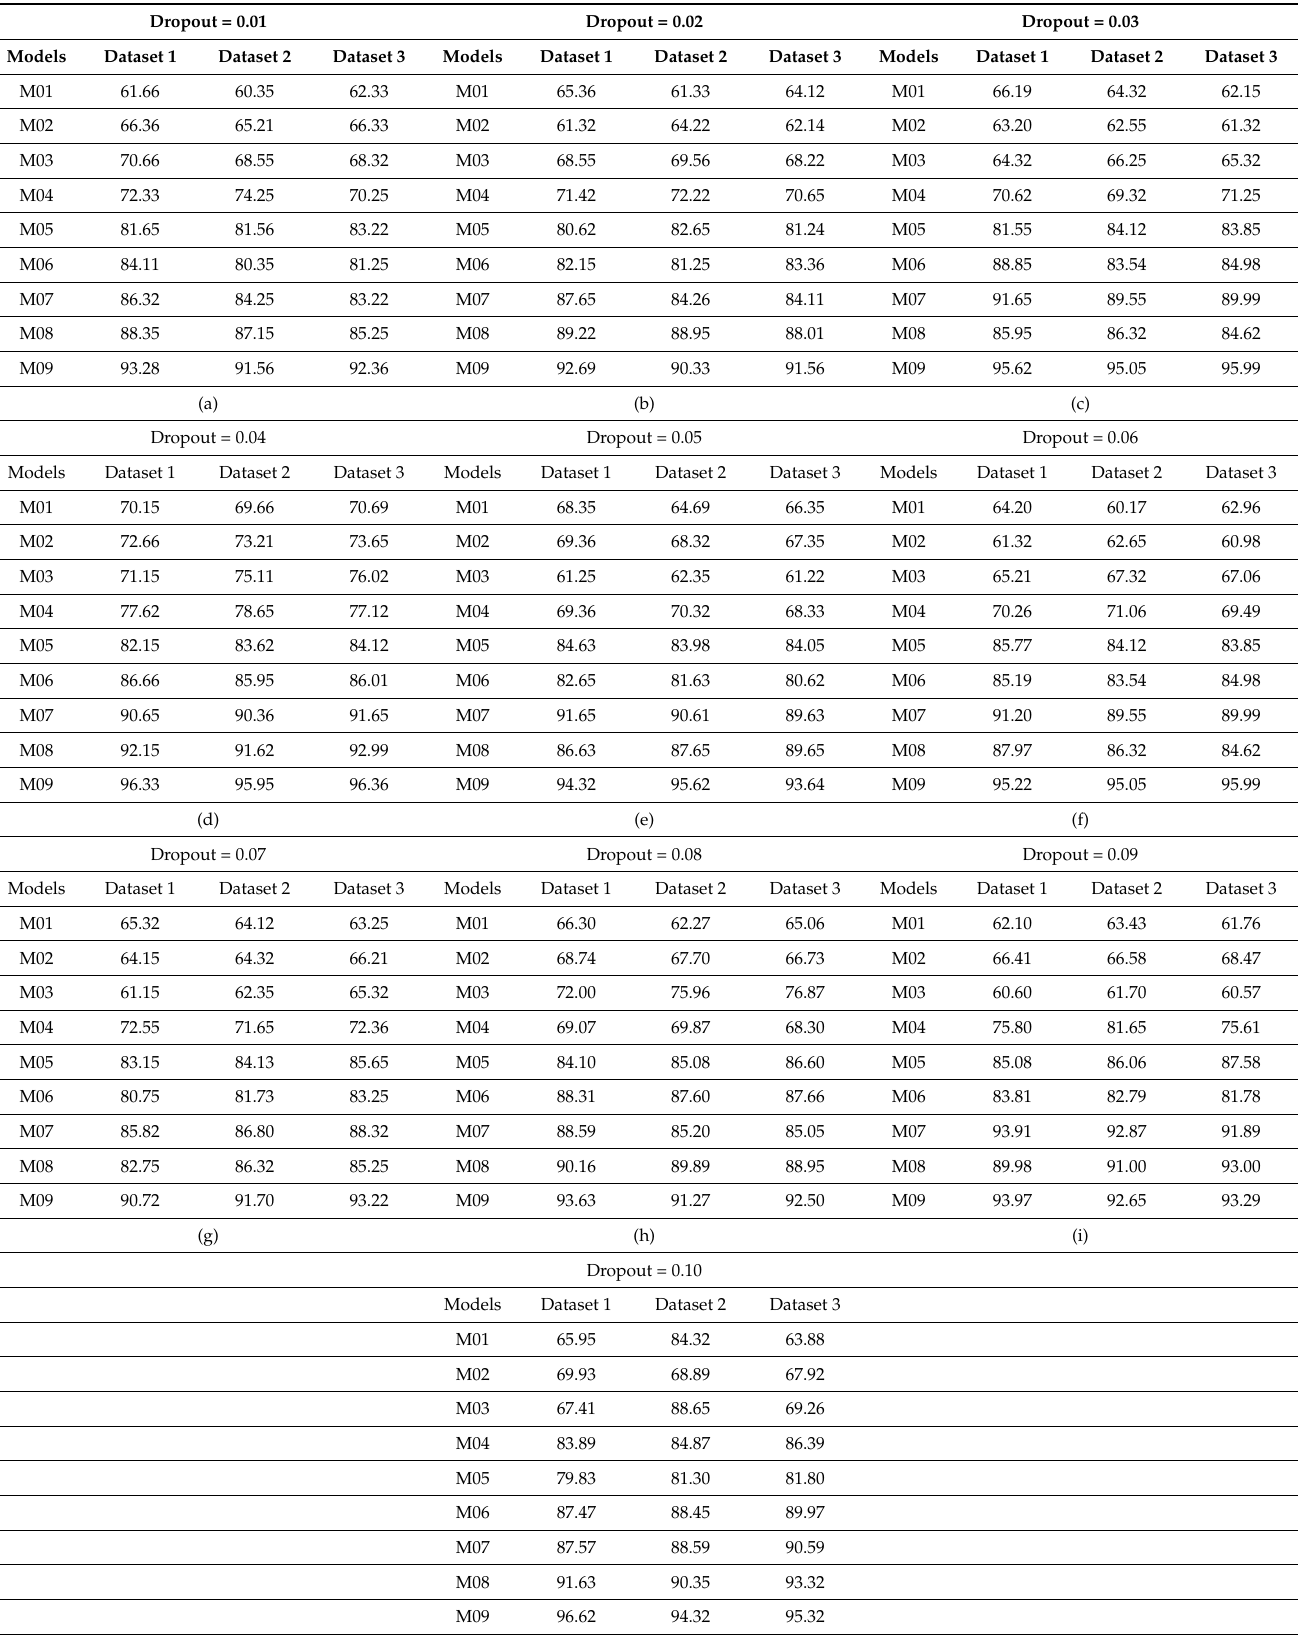
Table 5. The performance accuracy (%) for an embedding size of